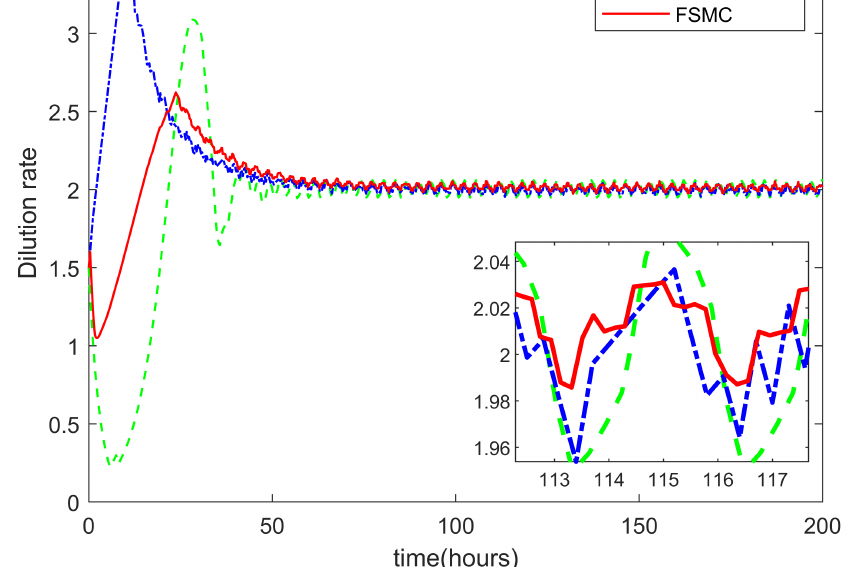
Figure 6. Biomass concentration.